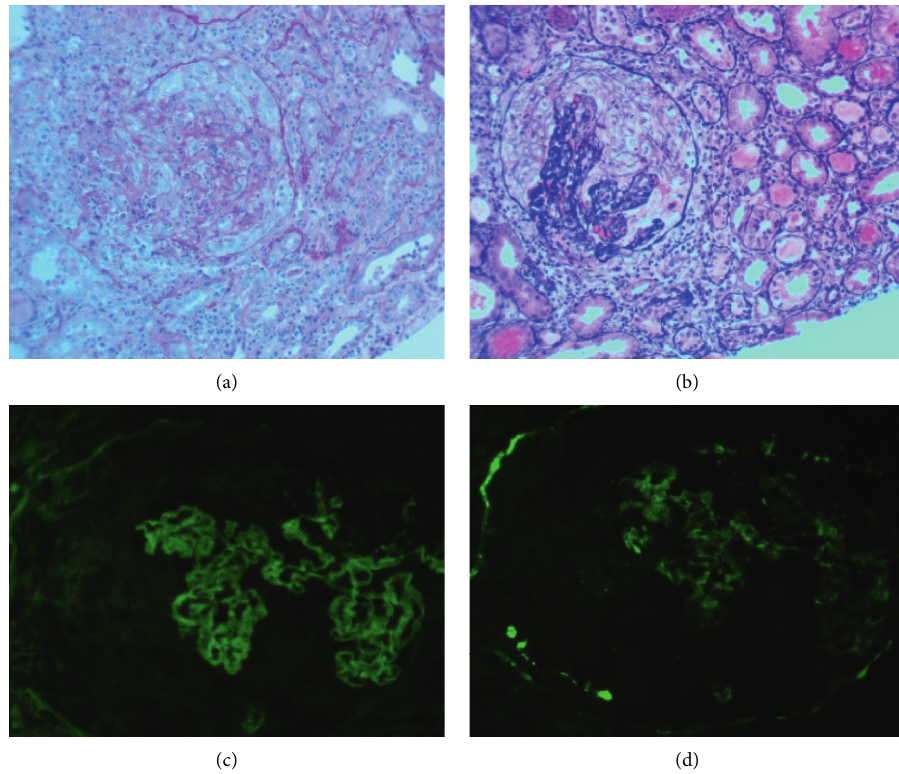
Figure 1: 27 glomeruli were seen on the renal biopsy specimen with the following histological findings. (a) Fibrocellular crescents in the glomeruli and lymphocyte infiltration around the tubule-interstitium near the glomerulus (periodic acid-Schiff (PAS) staining × 200). (b) Glomerulus with large crescent and collapsed tuft (Jones Silver staining × 200). (c, d) Immunofluorescence staining revealed linear staining along the glomerular capillary loops (IgG staining × 400).